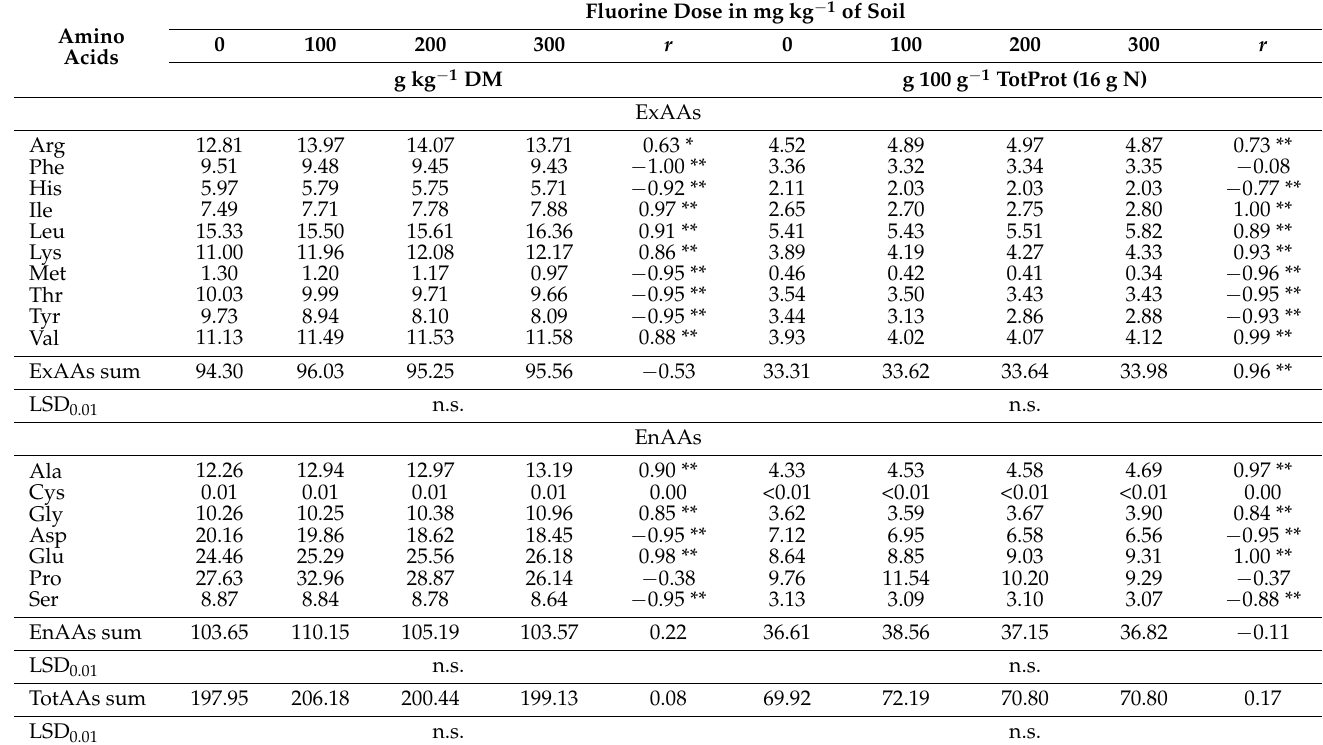
Table 3. The content of amino acids in above-ground parts of winter oilseed rape ( Brassica napus